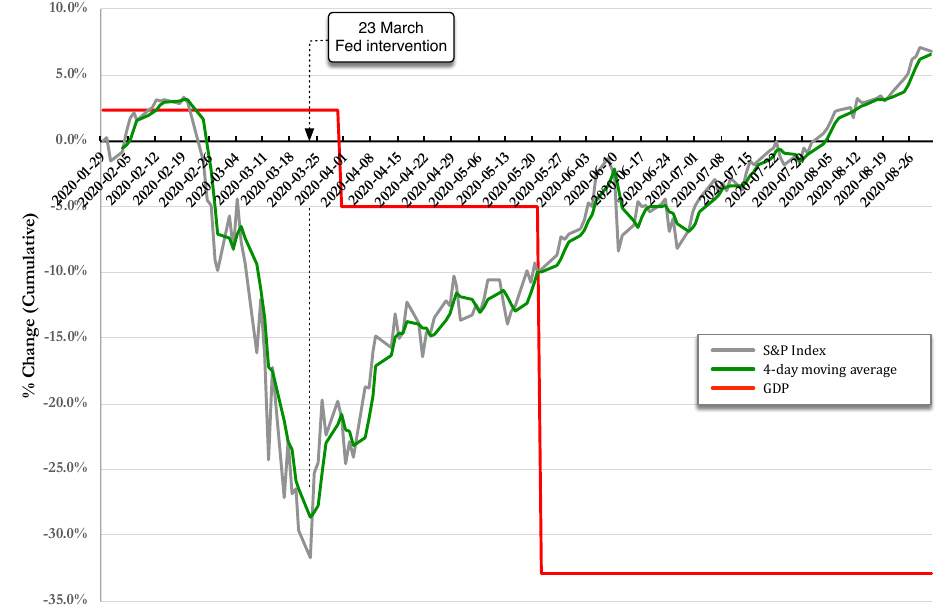
Figure 10. Cumulative % change in S&P Index during the 2020 pandemic (BEA 2020b; NASDQ